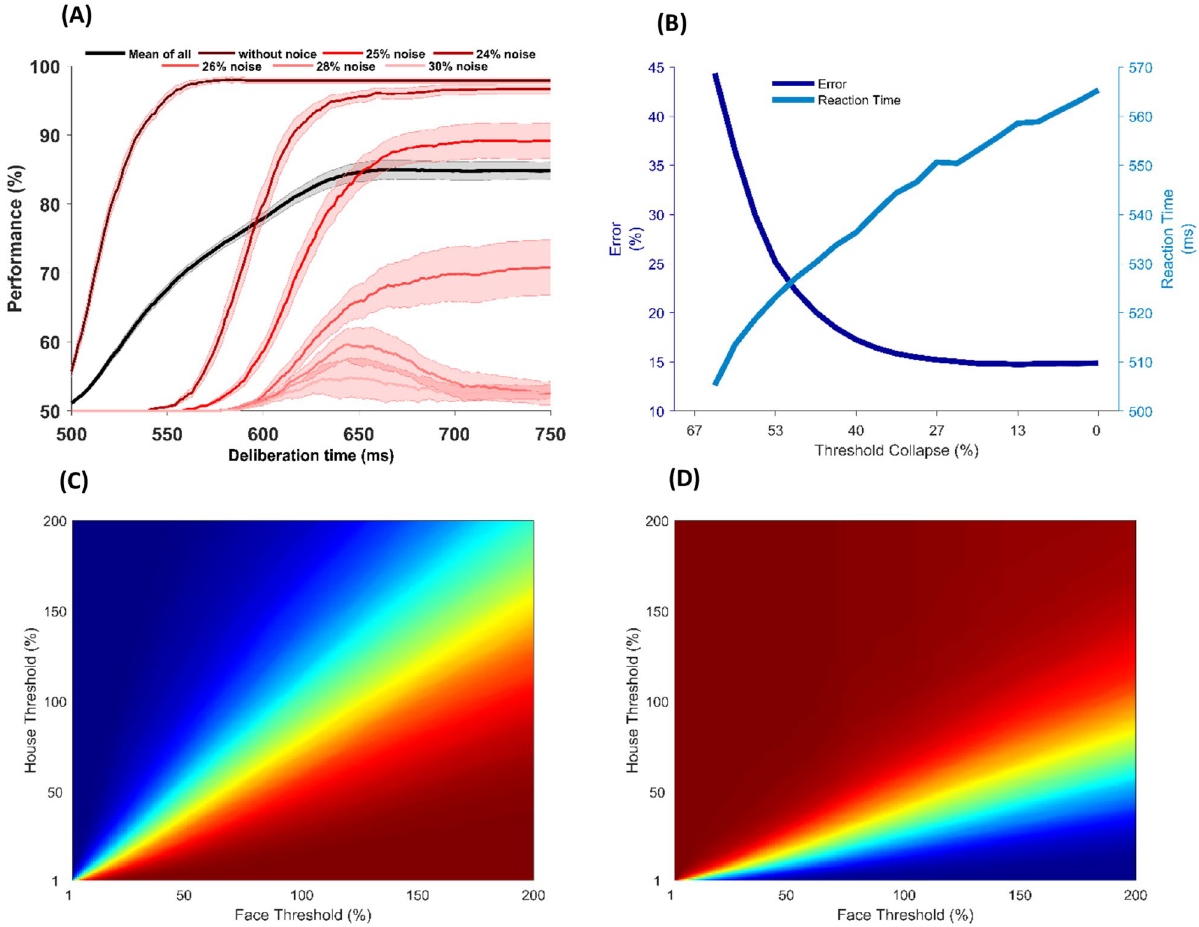
Figure 7. Temporal information is informative. ( A ) Having more time for information accumulation improves the performance. X-axis indicates the time that the model is allowed to accumulate spikes (deliberation time). Y-axis shows the performance of the model. The darker the red color, the less the noise level. The black color is the average of performance in all levels of noise. ( B ) Speed-accuracy trade-off can be controlled by threshold. The X-axis indicates the percentage of collapse in the decision bound. The left y-axis shows the error rate (dark blue curve) and the right y-axis shows the reaction time of the model. ( C ) Performance of face choices in different face and house threshold for noise level 26%. Warmer colors show a higher performance in face choices of the model. ( D ) Performance of house choices in different face and house threshold noise level 26%. Warmer colors show a higher performance in house choices of the